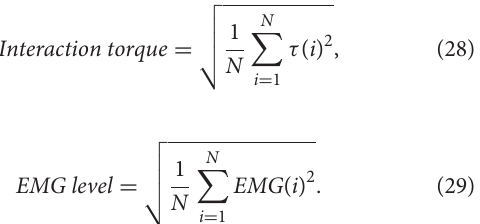
TABLE 1 | Measured and estimated joint stiffness (Nm/Rad) of one subject at different activation levels of TA.